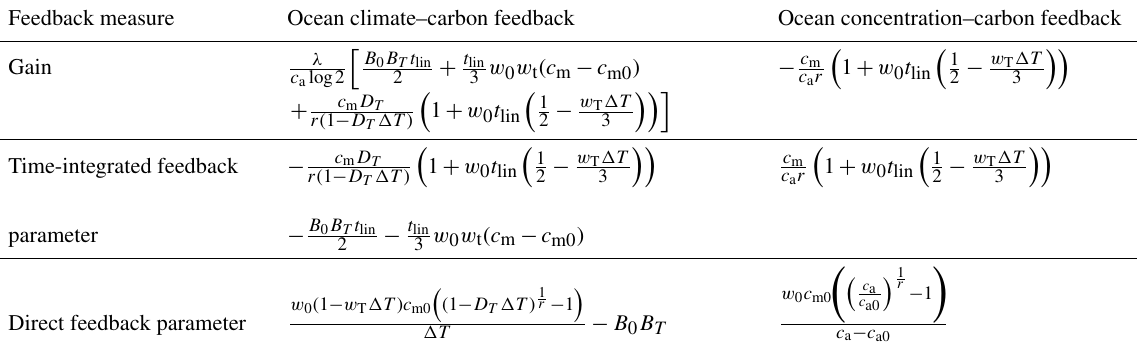
Table A1. Exact forms for ocean